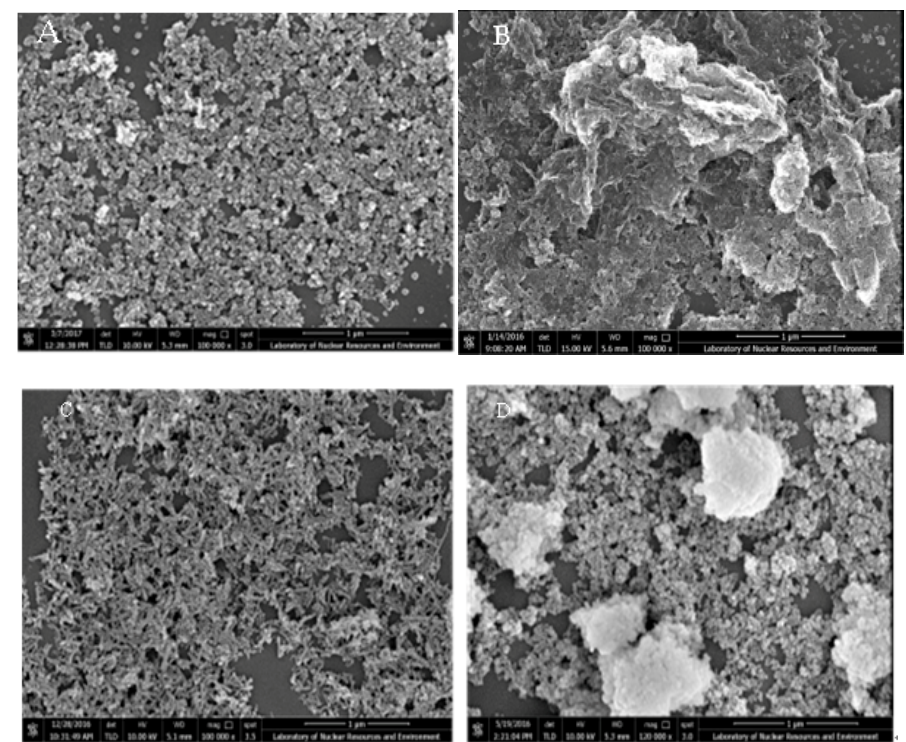
Figure 1. SEM image of ( A ) TiO 2 (20%)@CdS composite; ( B ) TiO 2 (30%)@CdS;( C ) TiO 2 (40%)@CdS; ( D ) TiO 2 (50%)@CdS.Magnification: ×100000, and the samples were sprayed with gold before measurement.